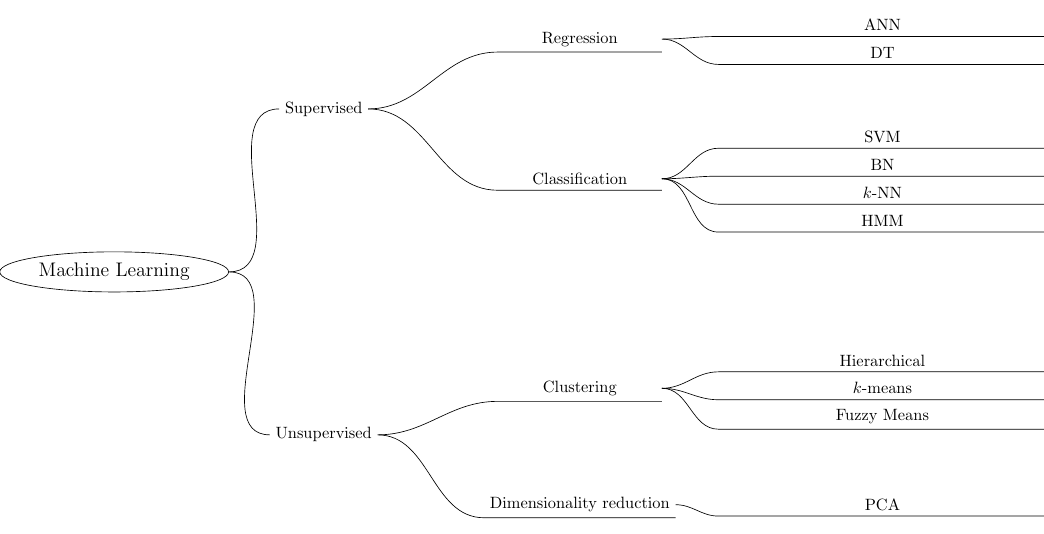
Figure 1. Machine learning